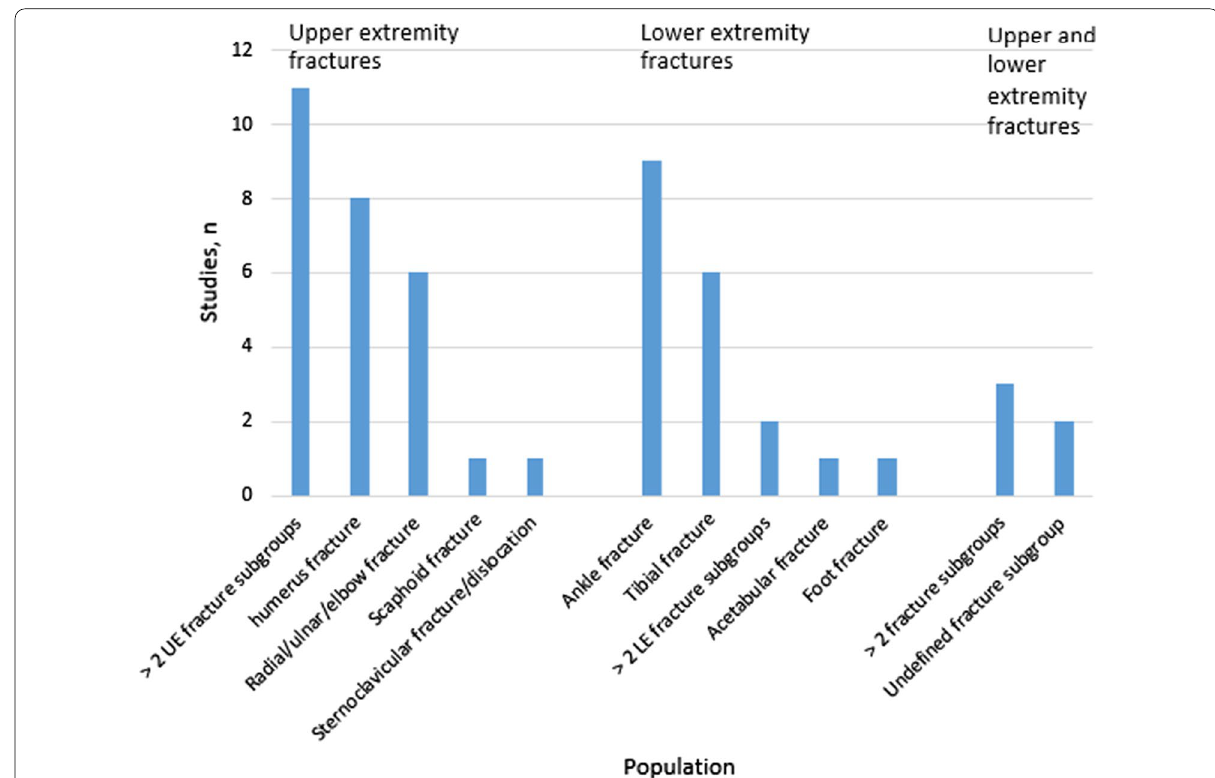
Fig. 2 Population and fracture subtypes included in this paper. UE: upper extremity, LE: lower